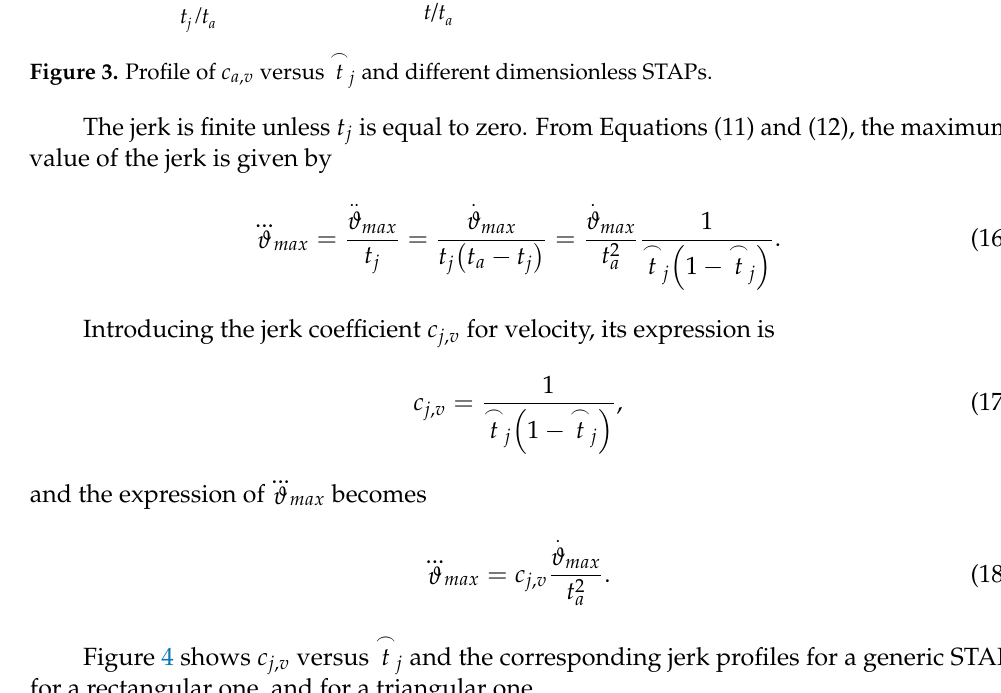
STAP, for a rectangular one, and for a triangular one.